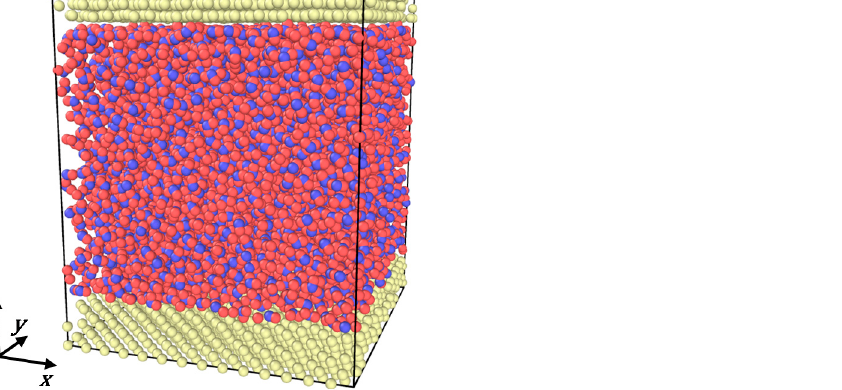
Figure 1. Visualisation of the simulated system.